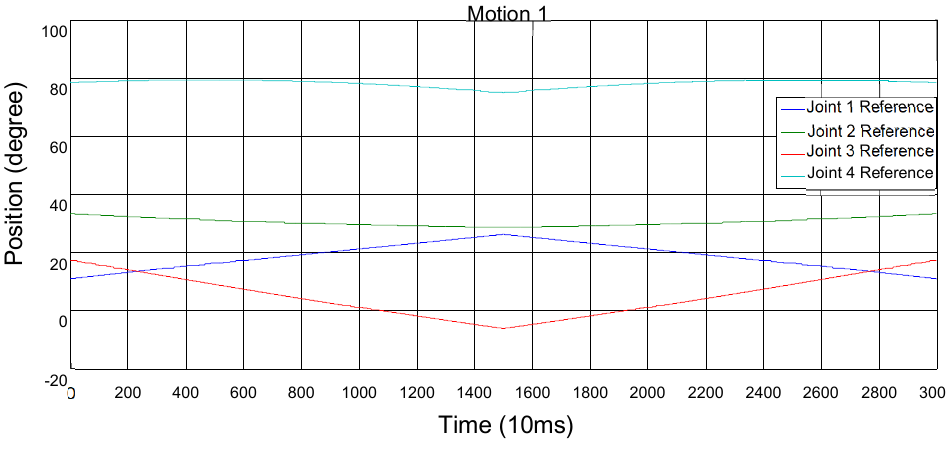
Figure 18. Motion trajectory 1 of each axis of the robot arm is planned by kinematics. Table 7. Rehabilitation trajectory 1—curvilinear equation in space. Rehabilitation Trajectory 1